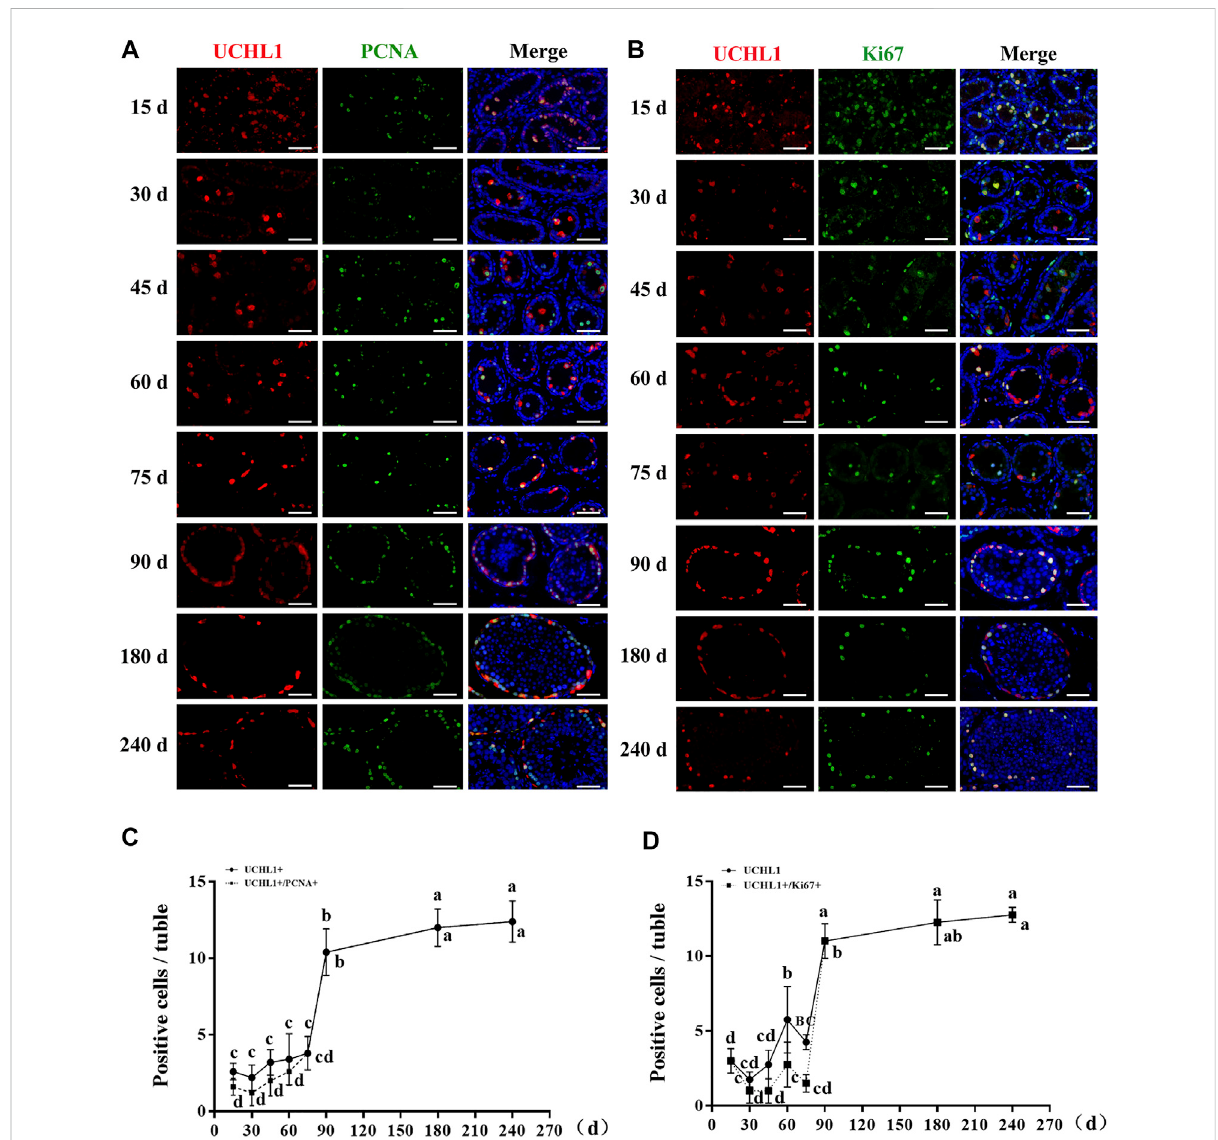
FIGURE 3 The proliferative activity of spermatogonia in dairy goat testes. (A) UCHL1 and PCNA immunostaining of dairy goat testis sections at each age. Bar=100 μ M. (B) UCHL1andKi67immunostainingofdairygoattestissectionsateachage.Bar=100 μ M. (C) ThenumbersofUCHL1/PCNA-positive cells per cross-section of seminiferous tubules in dairy goat testes at each age ( n = 9). (D) The numbers of UCHL1/Ki67-positive cells per cross- section of seminiferous tubules in dairy goat testes at each age ( n = 9). Different letters imply signi fi cant difference ( p < 0.05), and same letters mean no signi fi cant difference ( p >